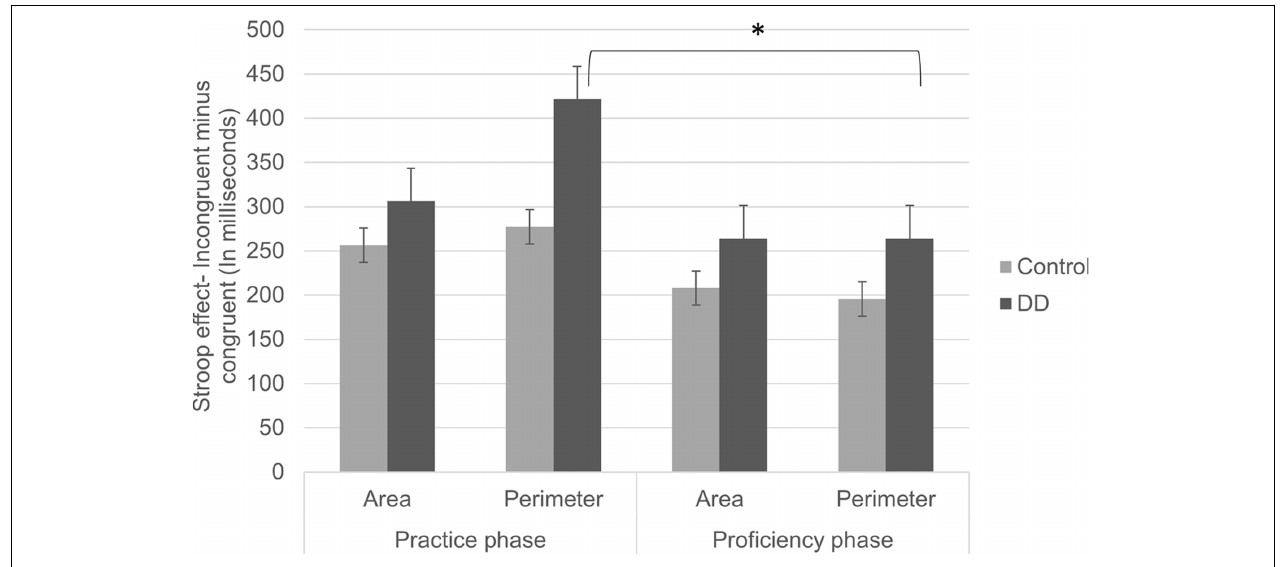
FIGURE 4 | Stroop effects (incongruent minus congruent trials) on RTs of practice and proficiency phases in both groups (DD and Control). Error bars depict ± 1 SE of the mean. Significance values: ∗ p <